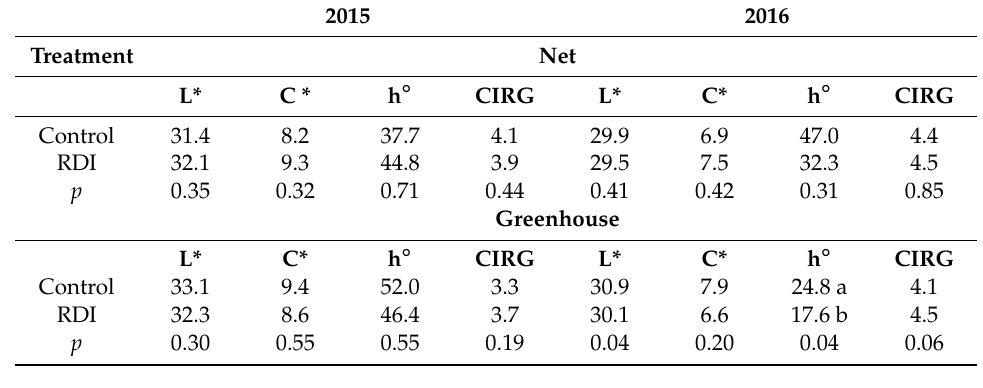
Table 6. Color parameters (Lightness (L*), chroma (C*), hue (h ◦ ) and CIRG) of ’Flame Seedless’ berries in the most representative picking operation in response to irrigation treatments (control and regulated deficit irrigation (RDI) in vines cultivated under net and greenhouse in 2015 and 2016. * in columns,